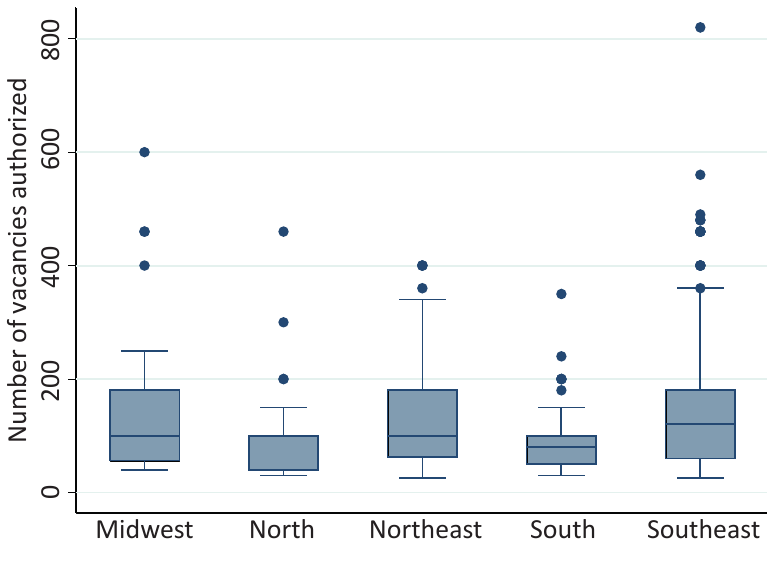
Figure 1 - Number of vacancies authorized by the Ministry of Education by Brazilian